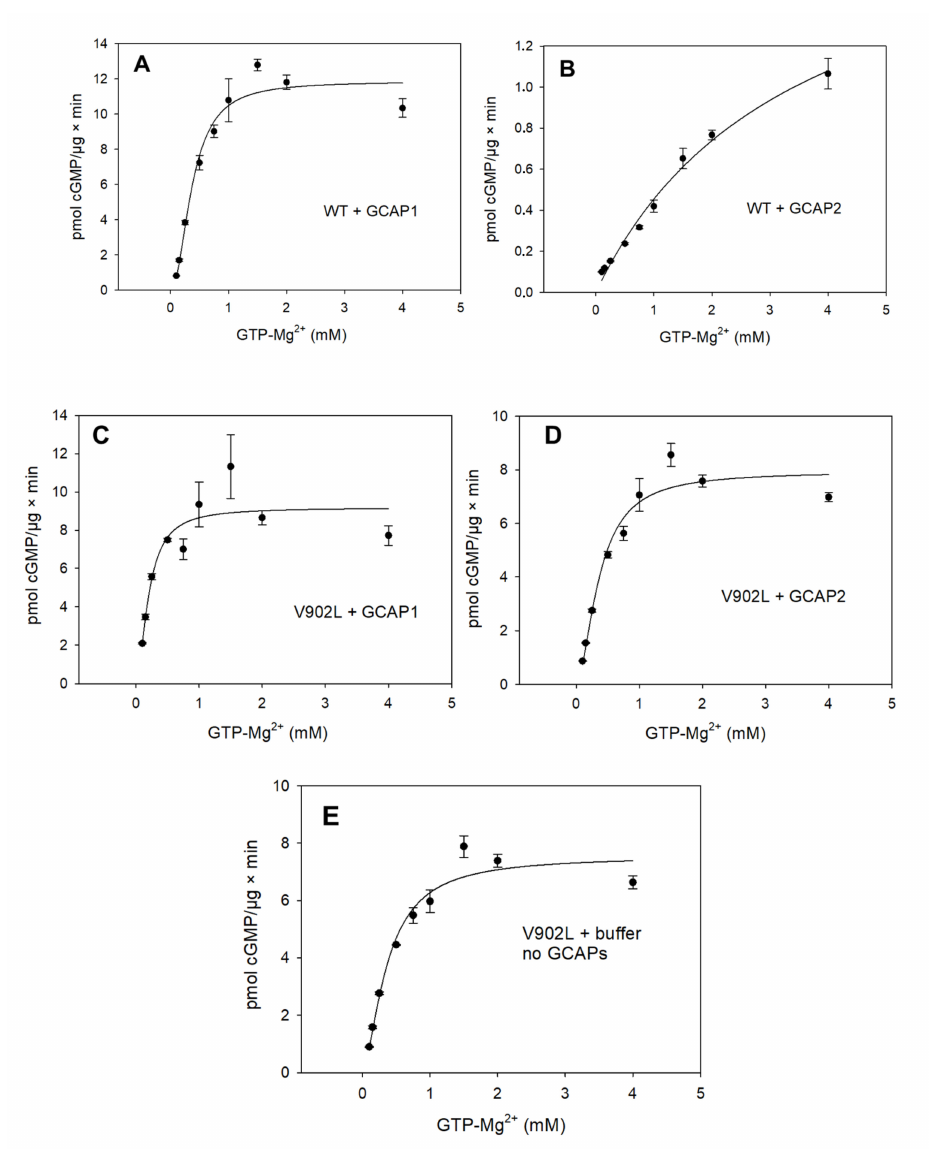
Figure 3. Functional analysis of WT and V902L mutant of human GC-E. Human GC-E variants were expressed in HEK293 cells and incubated with GCAP1 or GCAP2 at increasing Mg-GTP concentrations (in mM). Activities of WT GC-E in the presence of 5 µ M GCAP1 ( A ) or 5 µ M GCAP2 ( B ) ( n = 3). ( C , D ) The corresponding data sets obtained with the V902L mutant. ( E ) Constitutive activity of V902L in the absence of GCAPs. ( n =